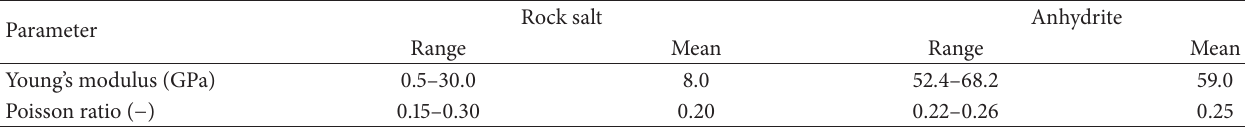
Table 2: Elastic parameters obtained for rock salt and anhydrite laboratory